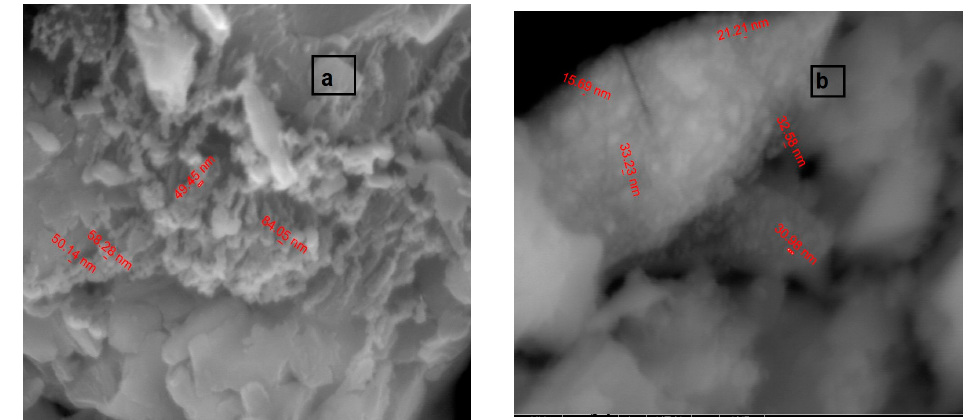
Figure 3. SEM graphs of ( a ) ligand and ( b ) [Cd(HL)(H 2 O) 2 Cl 2 ] complex.